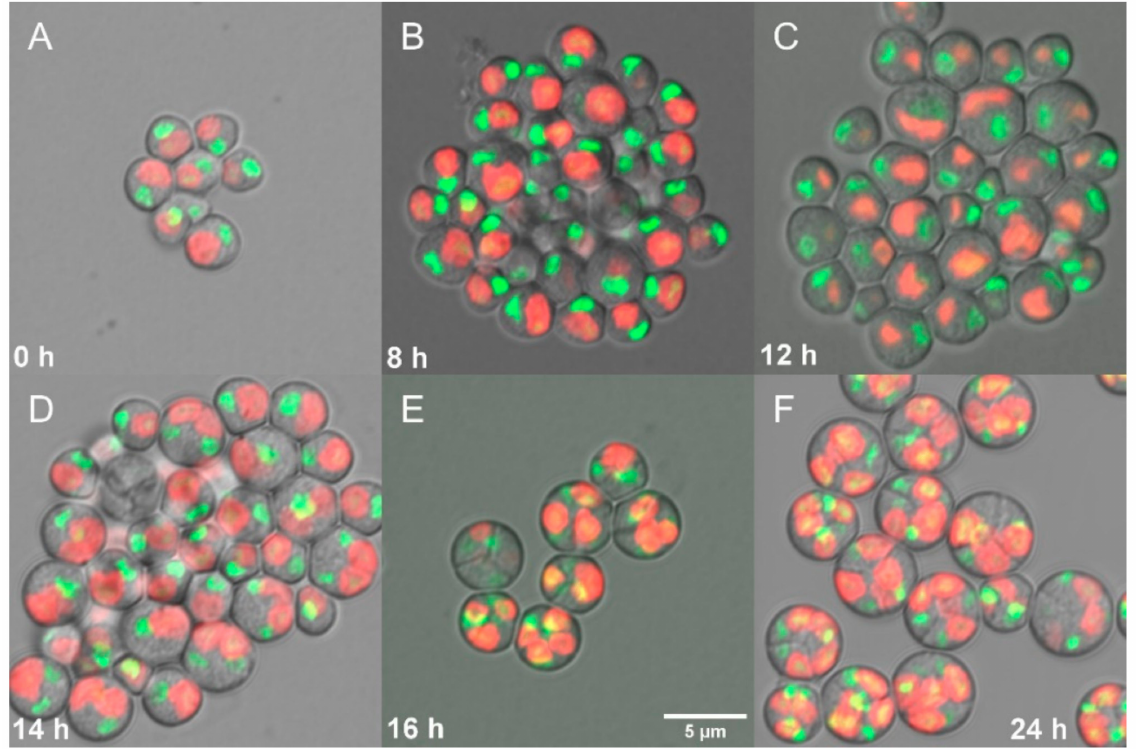
Figure 5. Fluorescent photomicrographs of a synchronous culture of Galdieria sulphuraria grown under optimal conditions (500 µ mol photons m − 2 s − 1 , 40 ◦ C, pH 3). Daughter cells (( A ) 0 h), growing single cells (( B ) 8 h), chloroplast and nuclei starting to divide (( C ) 12 h), division into 2 cells (( D ) 14 h), division into 4 cells, protoplast division apparent (( E ) 16 h), four daughter cells growing inside the original mother cell wall before their release (( F ) 24 h). Nuclei in green were stained by SYBR Green I, chloroplasts in red—autofluorescence of chlorophyll. The bar represents 5 µ